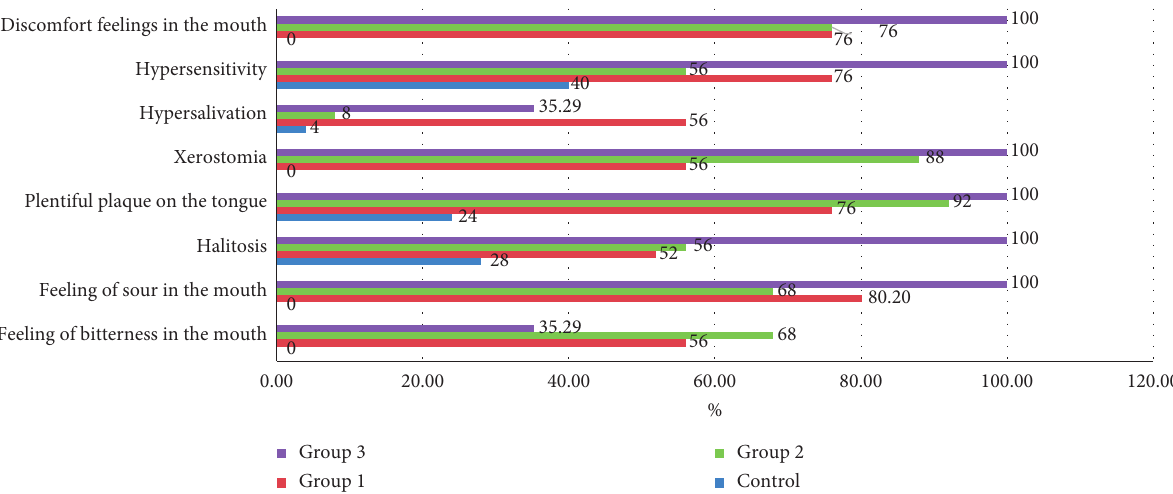
Figure 2: The comparative prevalence of dental complaints among patients with GERD with different types of